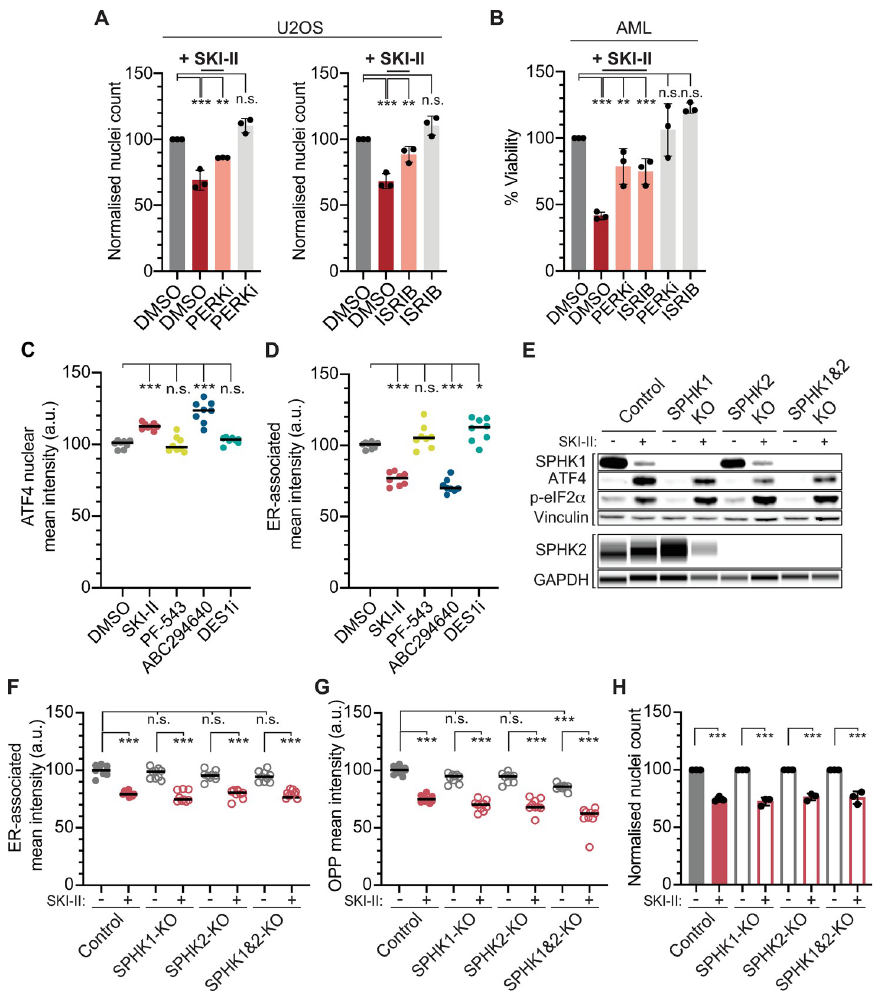
Fig 4. SKI-II lowers translation and kills cells independently of SPHKs. (A) HTM-dependent quantification of nuclei numbers (normalized to DMSO) in U2OS cells exposed to SKI-II (10 μ M), alone or in combination with PERKi (0.5 μ M) or ISRIB (10 nM) for 24 h. Cells were also solely exposed to PERKi and ISRIB at the indicated concentrations. Data A in S4 Data. Statistical analyses were done using one-way ANOVA tests. ��� p < 0.001. (B) Percentage of cellular viability (normalized to DMSO) measured with CTG in mouse AML cells exposed to SKI-II (1 μ M), alone or in combination with PERKi (3 μ M) or ISRIB (10 nM) for 24 h. Treatment with solely PERKi and ISRIB at indicated concentrations is shown. Data B in S4 Data. Statistical analyses were done using one-way ANOVA tests. ��� p < 0.001. (C) HTM-mediated quantification of ATF4 nuclear signal in U2OS cells treated with SKI-II (10 μ M), the SPHK1 inhibitor PF-543 (10 μ M), the SPHK2 inhibitor ABC294640 (50 μ M), or the DES1 inhibitor DESi (10 μ M) for 3 h. Data C in S4 Data. (D) HTM-mediated quantification of the mean intensity of the ER signal (measured by Cell Painting) in U2OS cells treated as in (D). Data D in S4 Data. (E) WB of markers of activation of the ISR (ATF4 and p-eIF2 α ) in parental U2OS cells (control) and in U2OS cells deficient for SPHK1 (SPHK1 KO), SPHK2 (SPHK2 KO), or both (SPHK1&2 KO), as shown by SPHK1 and SPHK2 antibodies, exposed to SKI-II (10 μ M, 3 h) for 3 h. (F) HTM- dependent quantification of ER-associated mean intensity in parental U2OS cells (control) and in U2OS cells deficient for SPHK1 (SPHK1 KO), SPHK2 (SPHK2 KO), or both (SPHK1&2 KO) exposed to SKI-II (10 μ M, 3 h). Data F in S4 Data. (G) HTM-mediated quantification of OPP signal in cells treated as in (G). In HTM quantifications, every dot represents the mean value of the measurements taken by well from 3 independent experiments. Data G in S4 Data. Statistical analyses were done using one-way ANOVA tests. ��� p < 0.001.(H) HTM-dependent quantification of nuclei numbers (normalized to control) of parental U2OS cells (control) and in U2OS cells deficient for SPHK1 (SPHK1 KO), SPHK2 (SPHK2 KO), or both (SPHK1&2 KO) exposed to SKI-II (10 μ M) for 24 h. Data H in S4 Data. Statistical analyses were done using one-way ANOVA tests. ��� p < 0.001. AML, acute myeloid leukemia; ATF4, activating transcription factor 4; CTG, Cell Titer Glo; DMSO, dimethyl sulfoxide; ER, endoplasmic reticulum; GAPDH, glyceraldehyde 3-phosphate dehydrogenase; HTM, high-throughput microscopy; ISR, integrated stress response; ISRIB, integrated stress response inhibitor; KO, knockout; n.s., not significant; OPP, o-propargyl-puromycin; p-eIF2 α , phosphorylated eIF2 α ; PERKi, PERK inhibitor; SPHK, sphingosine kinase; WB, western blotting.